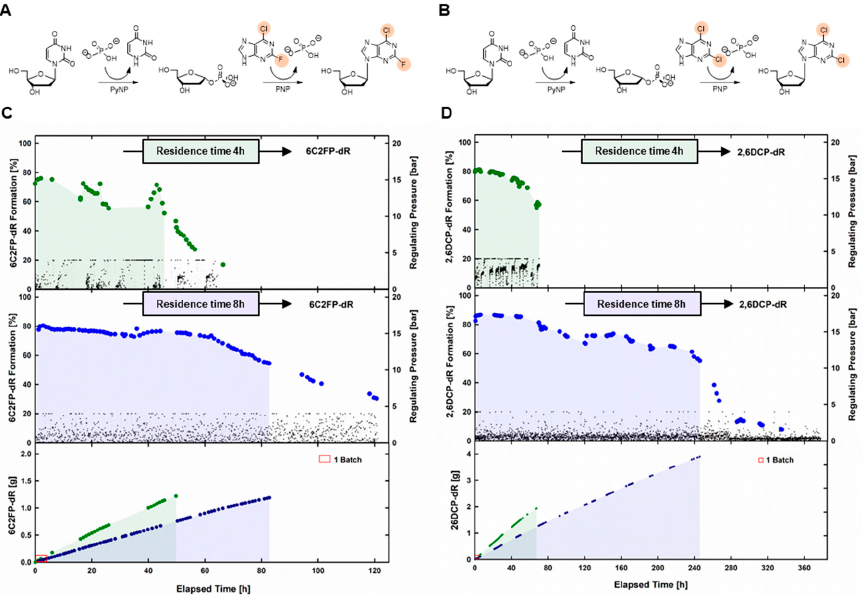
Figure 4. Continuous production of modified nucleosides from thymidine (25 mM) and 10 mM 6-chloro-2-fluoro-purine ( A , C ), or 2,6-dichloropurine ( B , D ), using purified pyrimidine and purine nucleoside phosphorylases (150 U of PyNP 02, 1050 U of PNP 02, by BioNukleo GmbH) at 40 ◦ C, stirred at 200 rpm. Thymidine (Thd) cleavage and formation of the respective nucleoside at residence times of 4 and 8 h were monitored ( C , D ). The threshold value of conversion for the calculation of process parameters (Table 1) is indicated by the shaded area. Full data sets for the synthesis of the dihalogenated nucleosides are shown in Figure